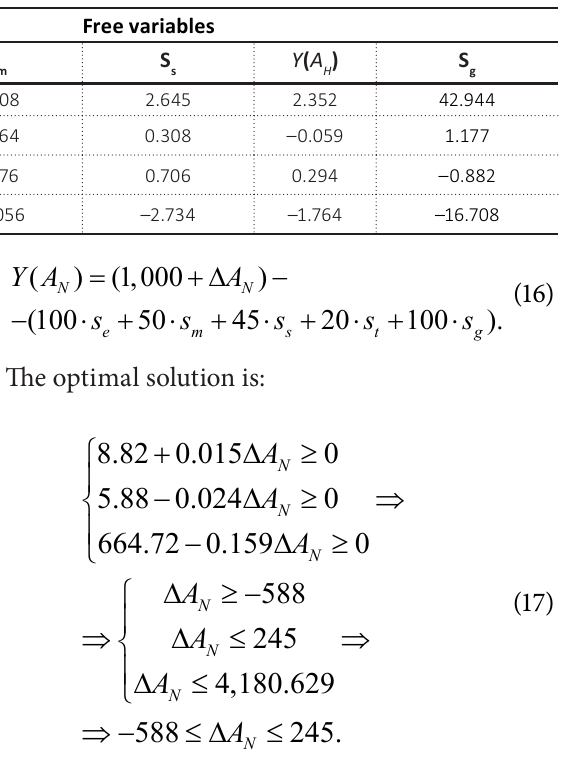
Table 4. Analysis of changes in the constraints of financial assets of “wow-effect” tourism on the final iteration of programming